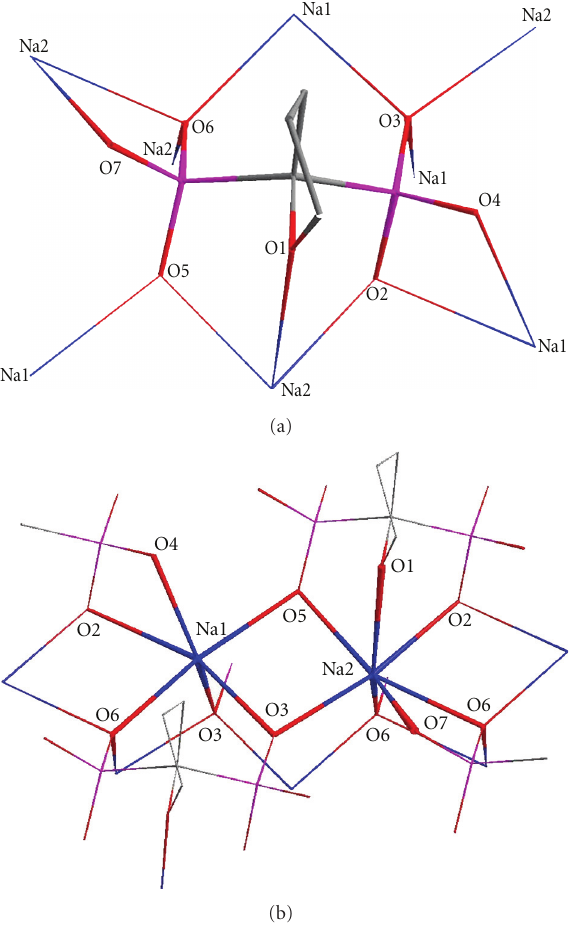
Figure 2: (a) Stick representation of H 2 L 2 − showing the connectiv- ity with sodium ions. (b) Stick representation of Na 2 H 2 L showing the coordination environment of sodium ions.